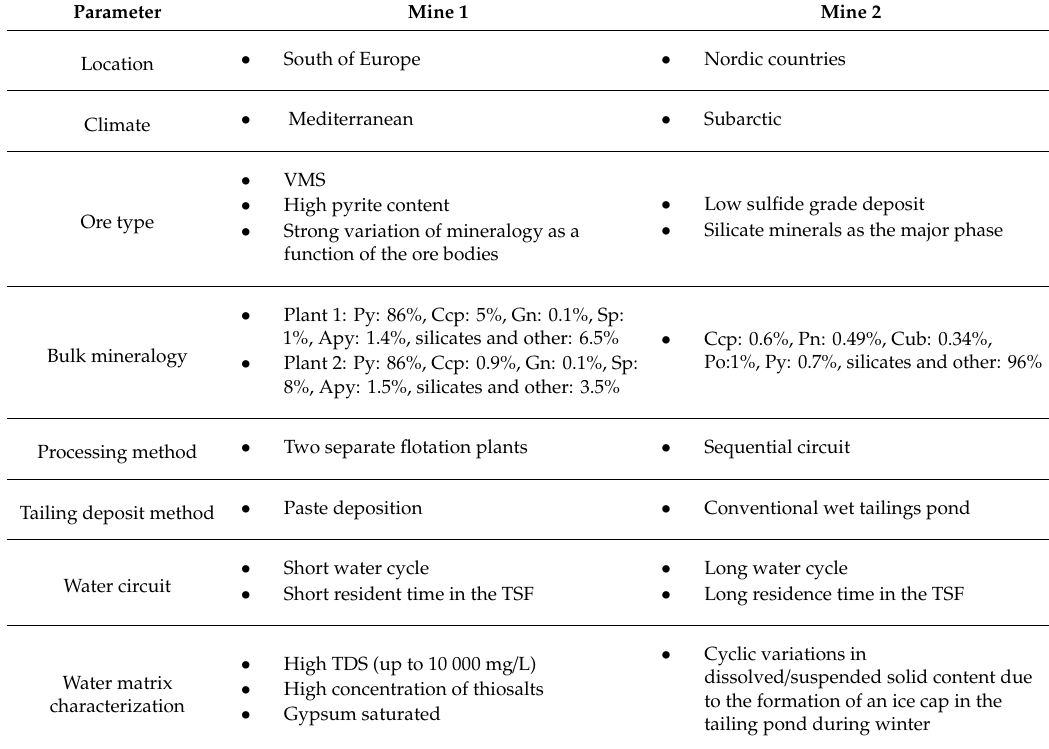
Table 1. Characteristics of Mine 1 and Mine